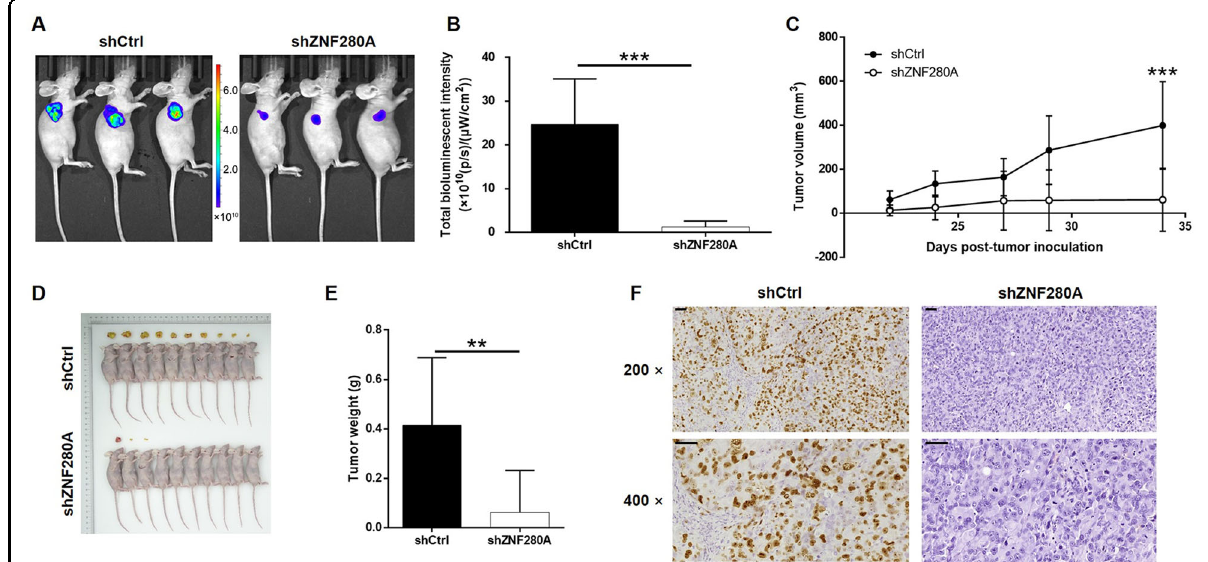
Fig. 3 ZNF280A knockdown inhibited LUAD development in vivo. A 22 days post injection of NCI-H1299 cells with or without ZNF280A knockdown, the volume of tumors formed in mice was measured and calculated at indicated time intervals. B In vivo imaging was performed to evaluate the tumor burden in mice of shZNF280A and shCtrl groups at day 34 post tumor inoculation. C The bioluminescence intensity was scanned and used as a representation of tumor burden in mice of shZNF280A and shCtrl groups. D , E Mice were killed at day 34 post injection, and the tumors were removed for collecting photos D and weighing E. F The expression of Ki67 in sections of xenografts was detected by IHC analysis (Scale bar = 50 μ m). Data were shown as mean ± SD. * P < 0.05, ** P < 0.01, *** P <